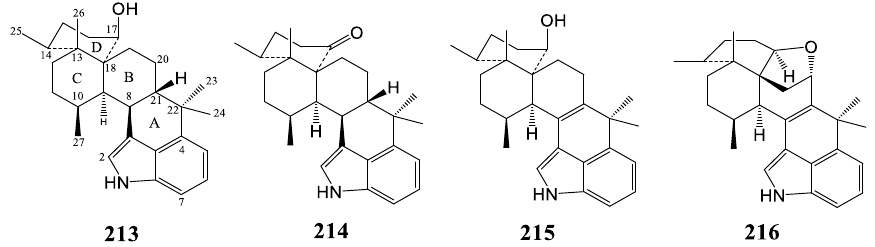
Figure 11. Structures of euijindole indole